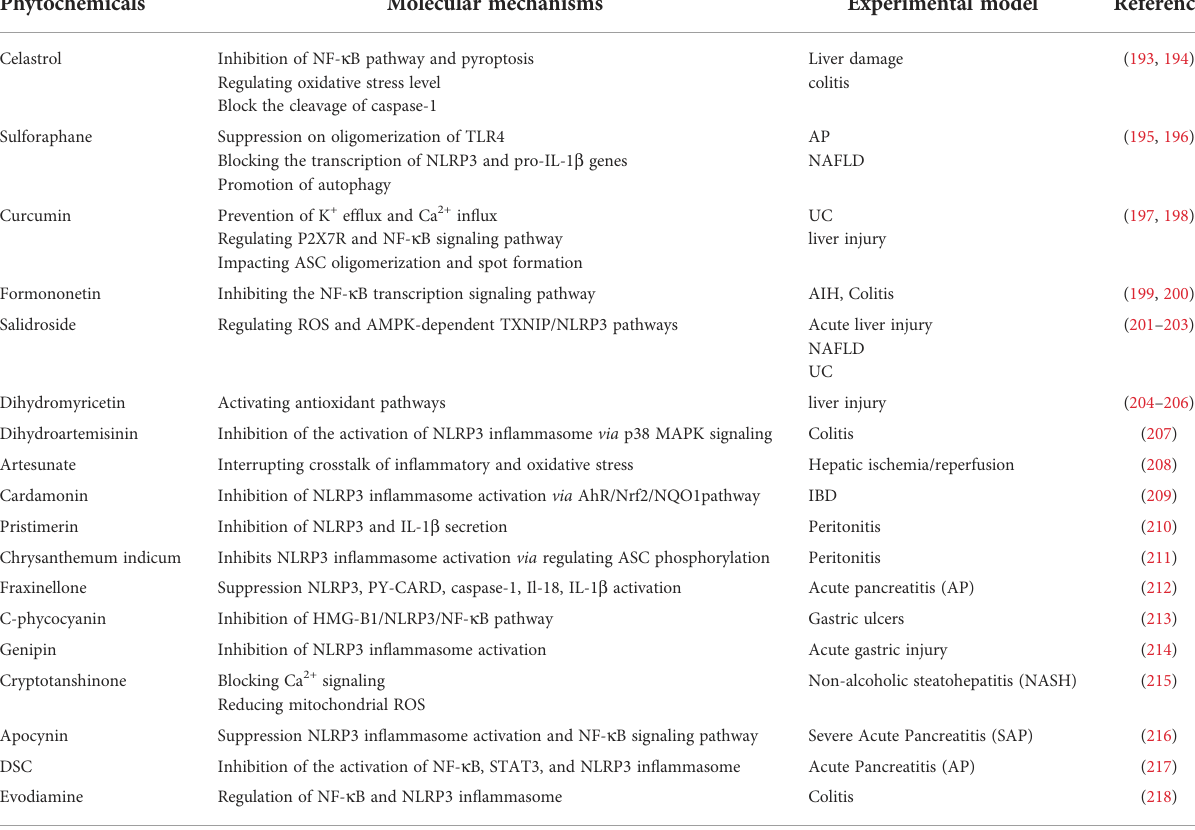
TABLE 4 Phytochemicals targeting on NLRP3 in fl ammasome in animal models of digestive